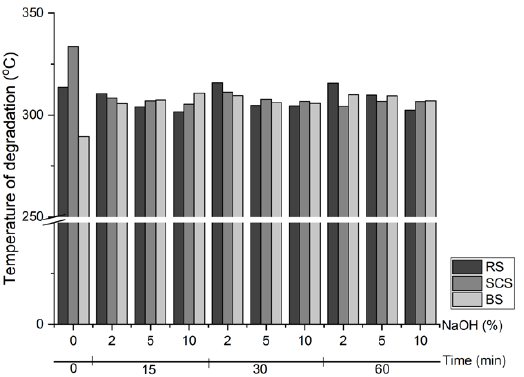
Figure 5. Second segment destruction temperature of untreated and treated RS, SCS, and BS fibers.